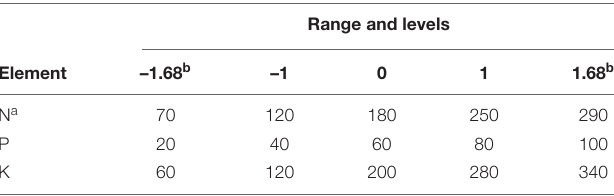
TABLE 2 | Range and levels of the experimental factors according to three-factor central rotatable composite design.